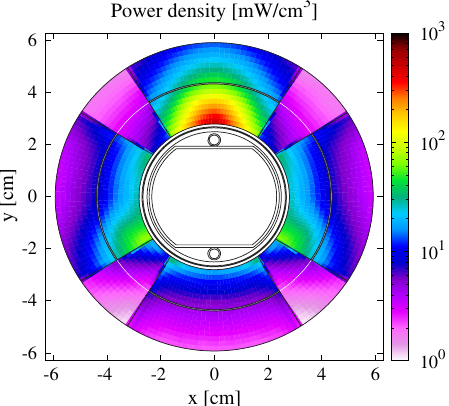
FIG. 21. Simulated transverse power density distribution from FLUKA during the dynamic orbit-bump quench test in MQ.14R2 coils at the position where the maximum energy deposition occurs. Results correspond to 2 . 54 × 10 9 protons impacting on the magnet beam screen. Spatial coordinates are with respect to the center of the vacuum